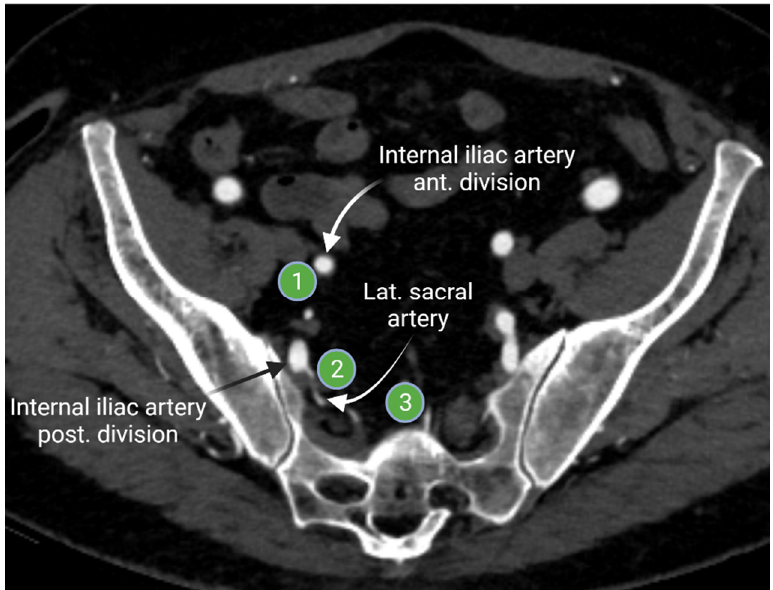
Figure 4. Axial contrast-enhanced computed tomography of the pelvis shows the anterior internal iliac lymph node group ( 1 ) that follows the course of the internal iliac artery anterior division, the lateral sacral lymph node group ( 2 ) that runs along the lateral sacral artery, and the presacral lymph nodes ( 3 ) that lies in the midline presacral region. “Created by BioRander.com. accessed on 10 August